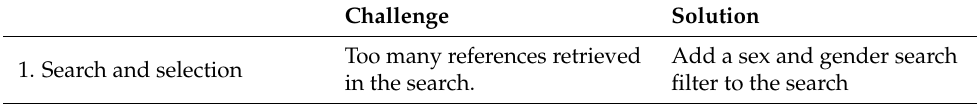
Table 2. Summary of challenges and solutions in a systematic review evaluating the role of sex as a prognostic